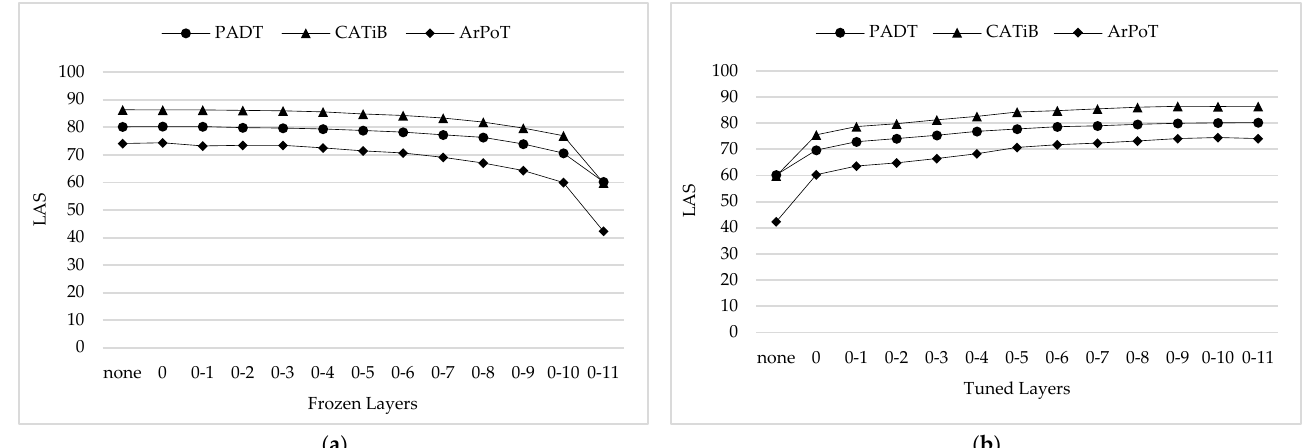
Figure 4. LAS of BERT-based pre-trained models on three corpora by ( a ) freezing an increasing number of layers during fine-tuning and ( b ) fine-tuning at earlier layers.